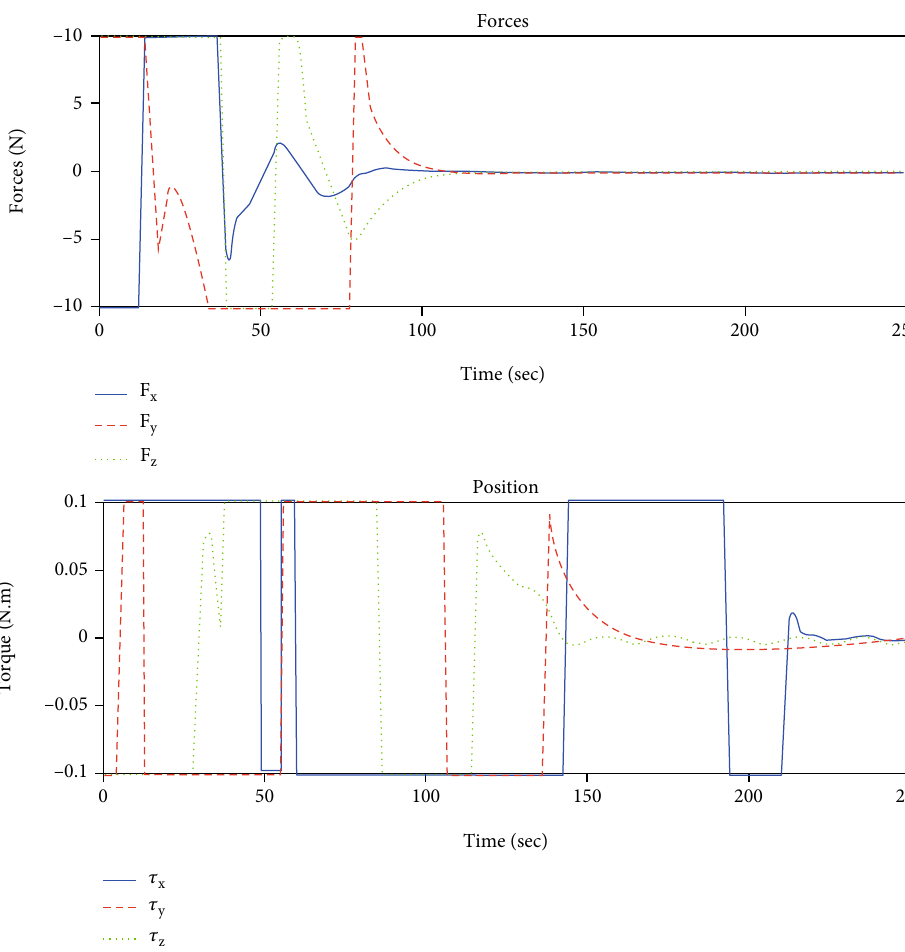
Figure 9: Time histories of control forces and torques expressed in the body- fi xed frame with the prediction of 15 sampling